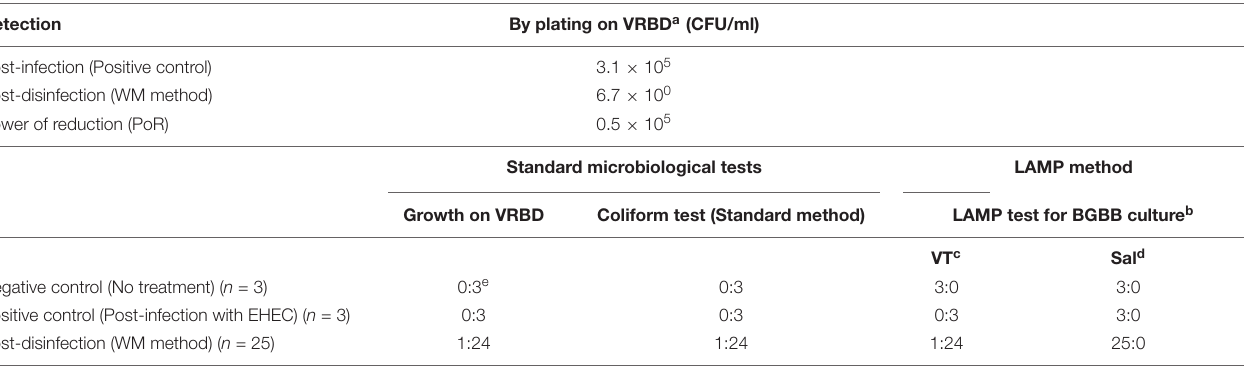
TABLE 2 | The result of one artificially contaminated beef with EDL933 treated by the WM method. Detection By plating on VRBD a (CFU/ml) Post-infection (Positive control)